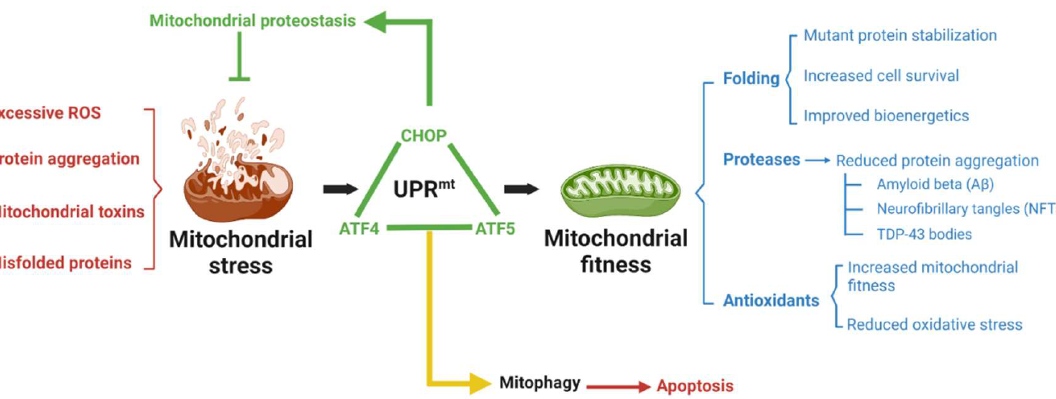
Figure 2. The UPR mt is a conserved adaptive mechanism for improving cell survival under mitochondrial stress. The UPR mt may act as a first line of defense against mitochondrial stress and involves communication between the stressed mitochondria and the nucleus. Activation of the UPR mt aims to restore protein homeostasis and function within the mitochondria, therefore preserving cellular functions. UPR mt is mainly regulated for a triad of proteins—ATF4, ATF5, and CHOP; however, although their interactions are not well stablished yet. Different reports have described the protective effects of UPR mt activation in various disease conditions, such as mitochondrial diseases, neurodegeneration, or heart diseases. However, after trespassing a certain stress threshold and to prevent the toxic effects of dysfunctional cell processes, affected mitochondria are eliminated via mitophagy, which ultimately will lead to apoptosis if the damage is irreversible. Figure was created with BioRender (BioRender.com).